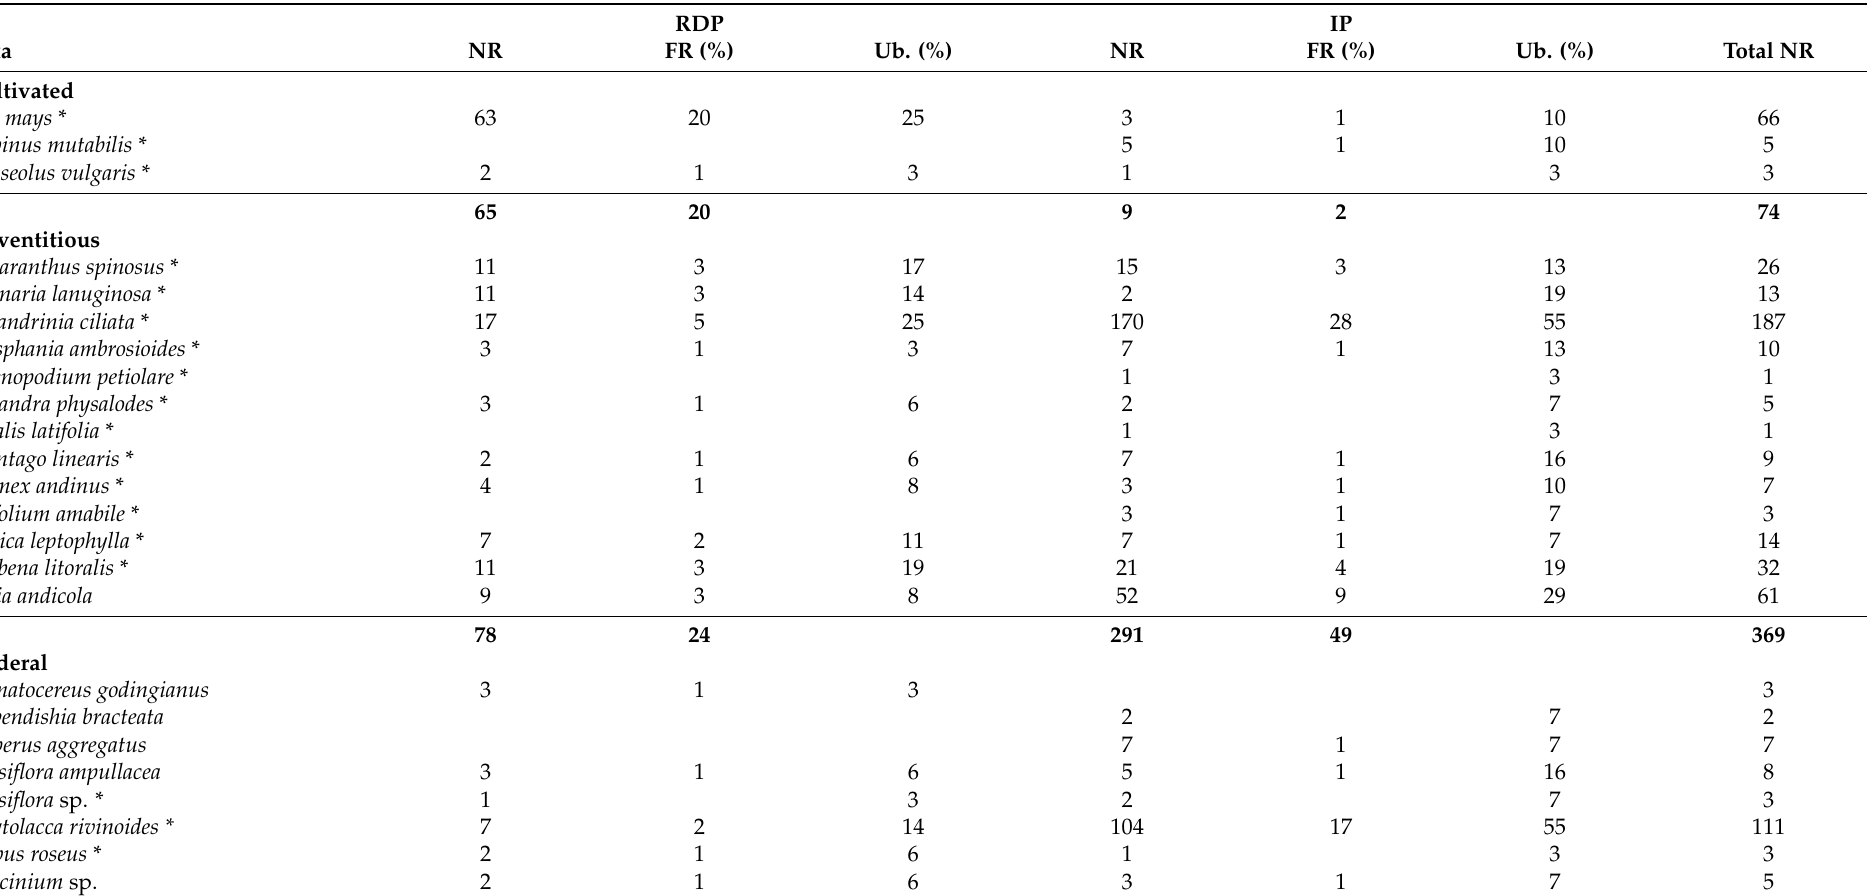
Table 7. Archeobotanical analysis of the charred macrobotanical assemblages of the Joyagzh í terraces. The results were merged by chronological period